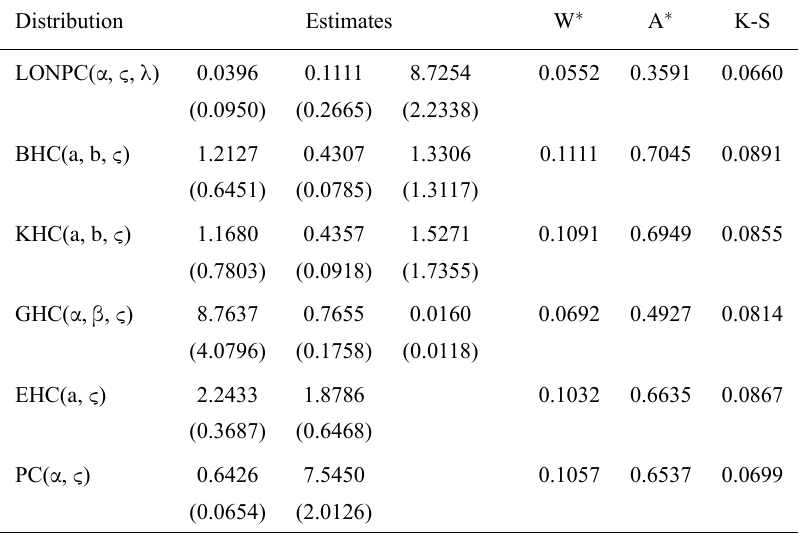
MLEs, their SEs (in parentheses) and goodness-of-fit measures for the Failure data.